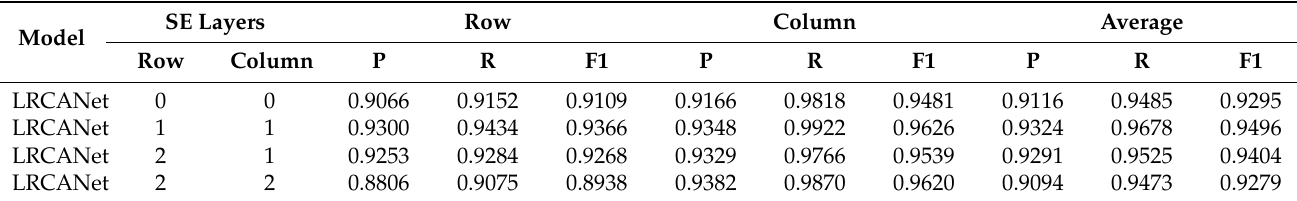
( b ) Figure 10. Comparison before and after adding SE module ( a ) without SE module; ( b ) with SE module.